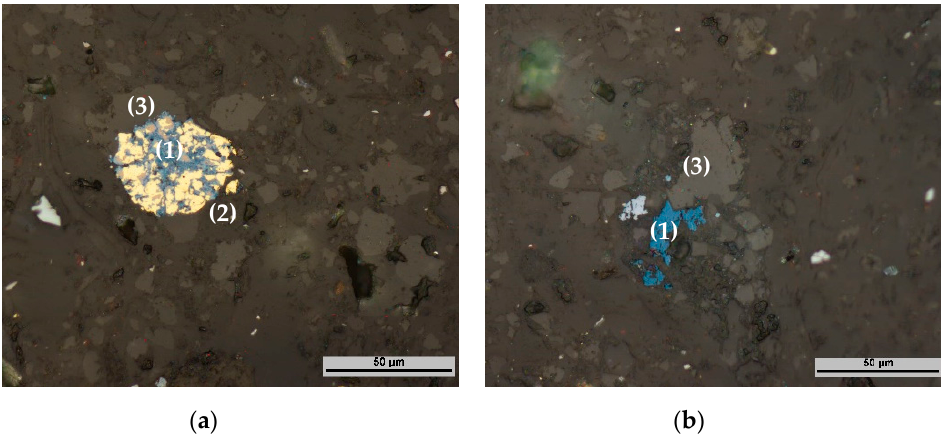
Figure 9. Examples of intergrowths of covellite (blue—1) and chalcopyrite (yellow—2) with carbonate (dark grey—3) ( a ) and covellite (1) with carbonate (3) ( b ).